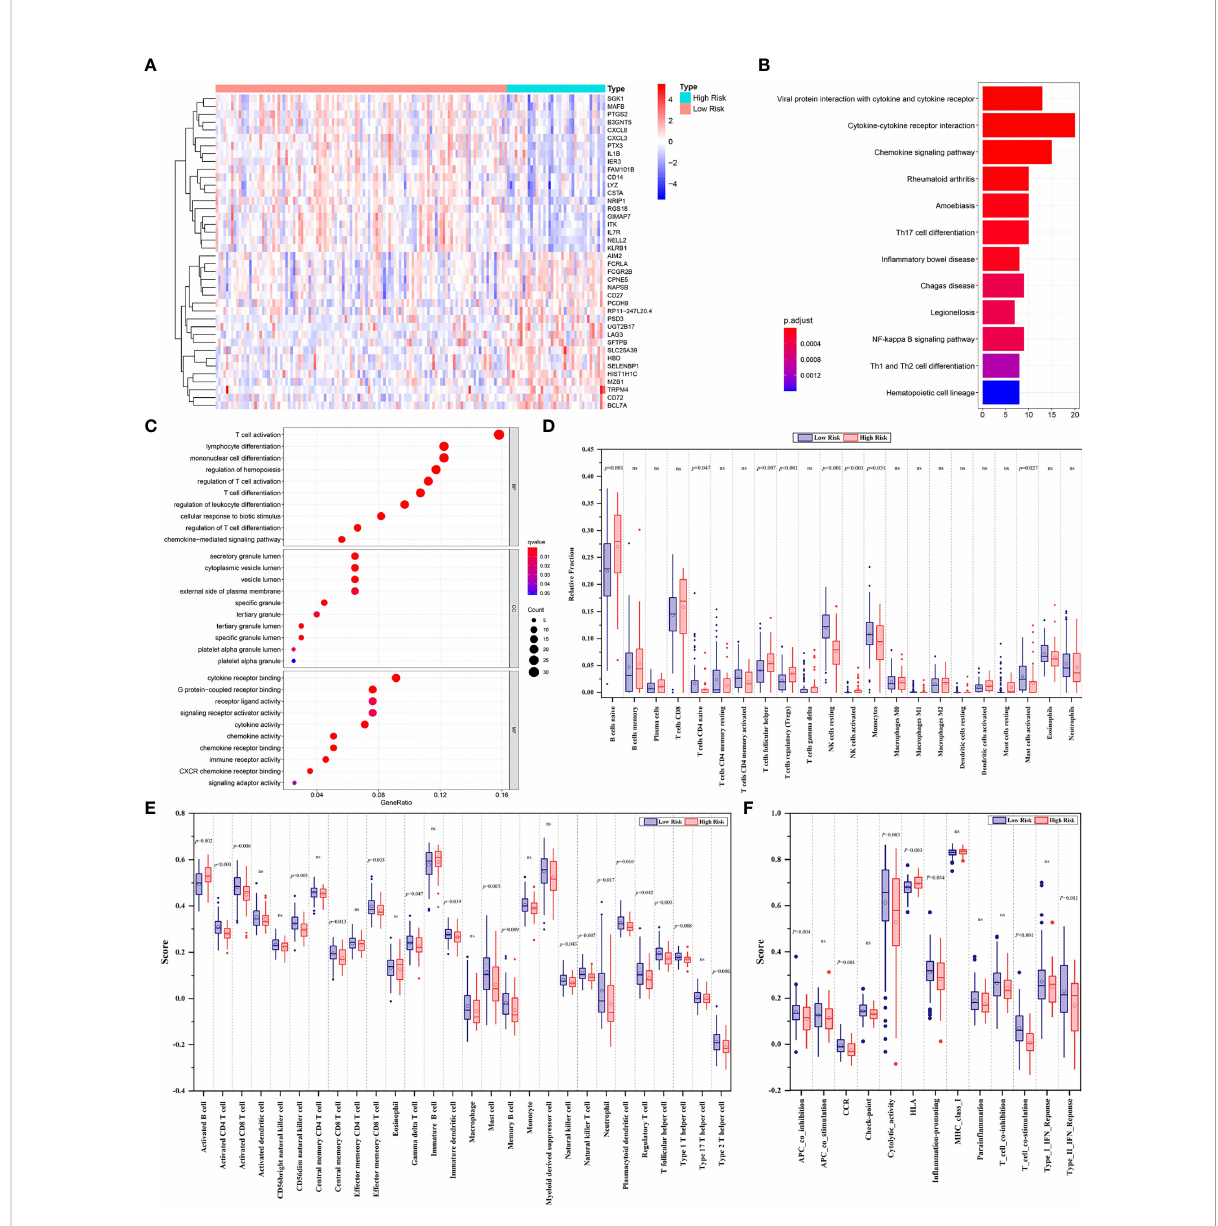
FIGURE 4 (A) The heatmap displaying the differentially expressed genes between the low- and high-risk groups. The representative results of KEGG pathways (B) and GO analysis (C) of DEGs between two groups. (D) Boxplots of the relative fraction of 22 immune cell types between two groups. (E, F) The score of immune cell types and immune-related functions using ssGSEA analysis, respectively. ns, no signi fi